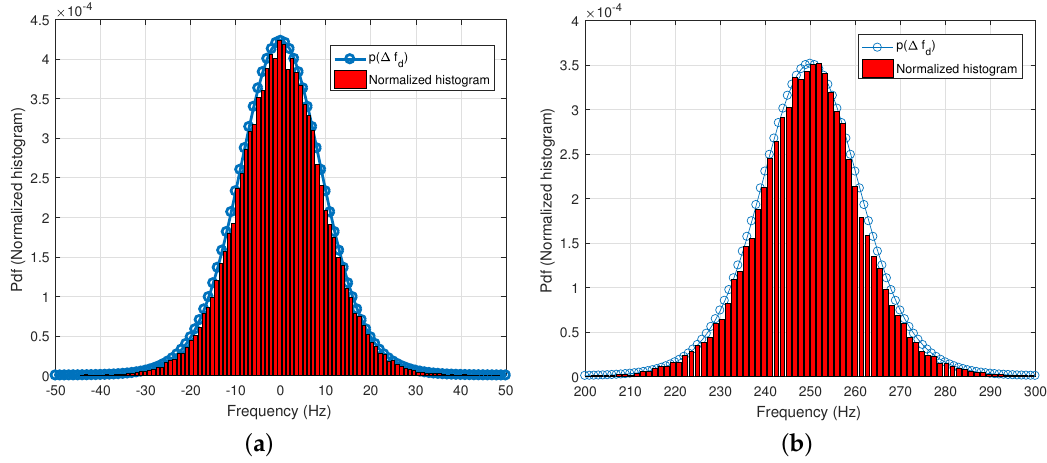
Figure 4. The probability density function of estimated frequency by the Conventional Differential Combination (CDC) method versus histograms (obtained by 500,000 simulation runs) ( a ) (cid:52) f = 0 Hz; ( b ) (cid:52) f = 250